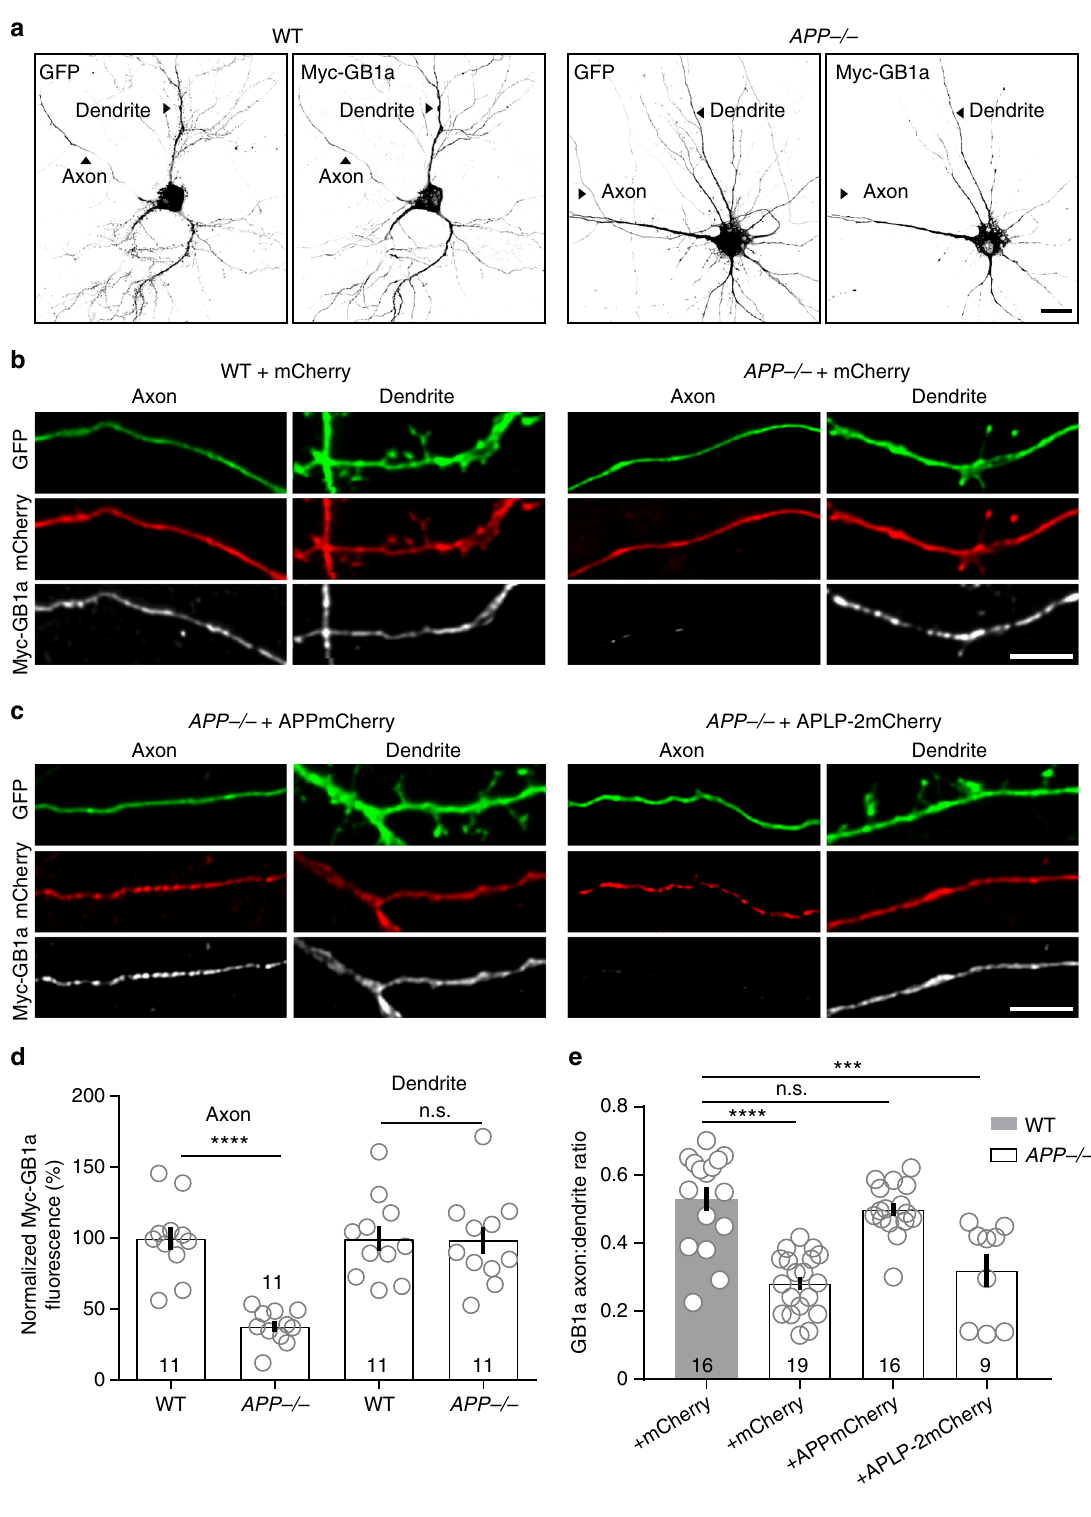
activation upon sAPP α application. Brain membranes of APP − / −